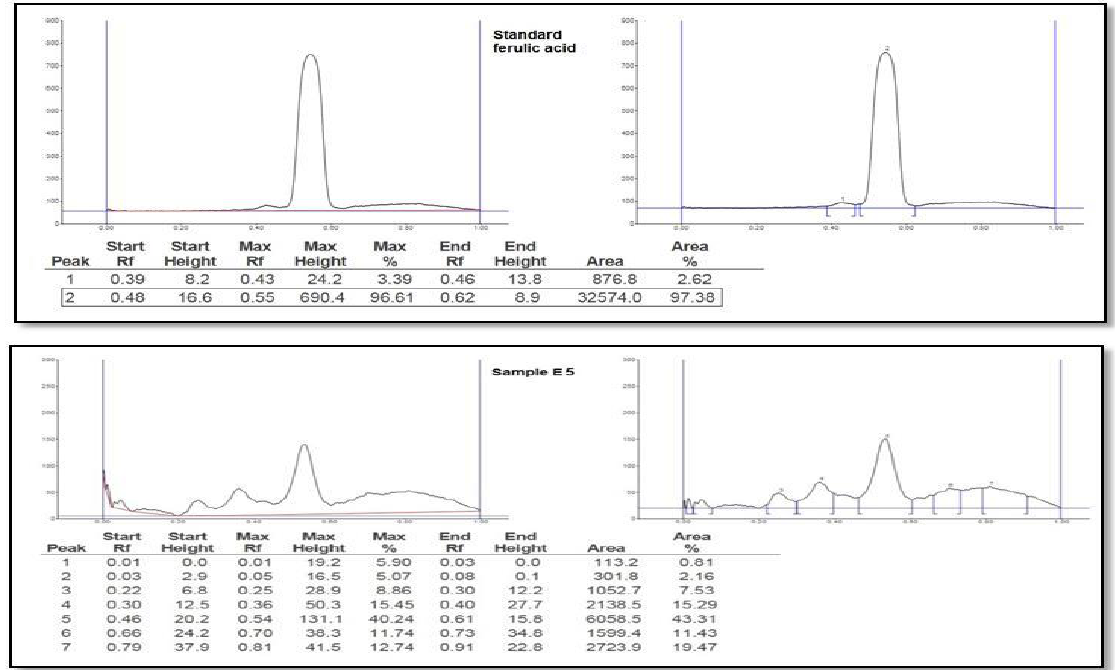
Figure 6. HPTLC chromatogram of standard and sample E2 chlorogenic acid at 254nm.